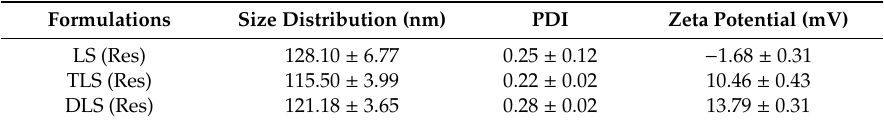
Table 1. Size, polydispersity index (PDI) and zeta potential of LS (Res), TLS (Res) and DLS (Res). Mean ± S.E.M, n = 5.